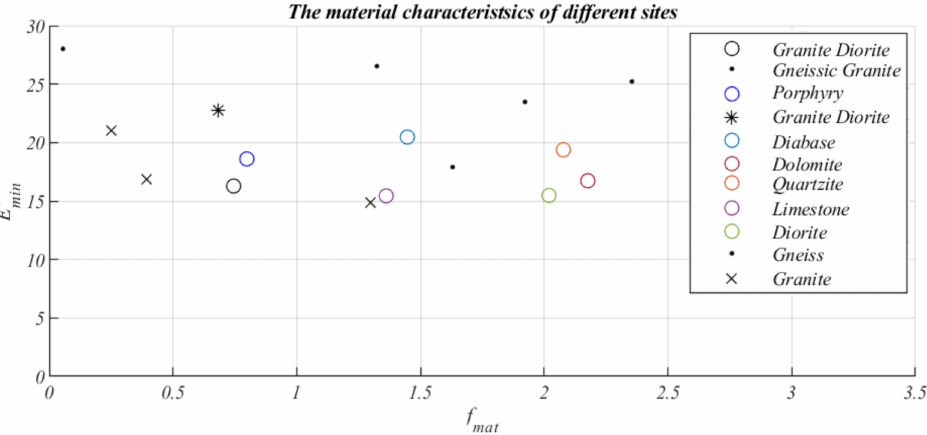
Figure 10. A scatter plot of the f mat and E 0 min values for different rock types and sites